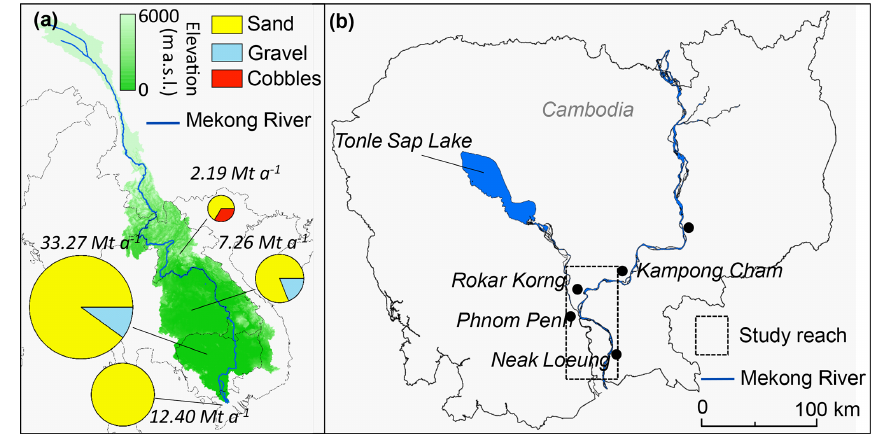
Figure 1. (a) Established sediment extraction rates (Mtyr − 1 ) across the Mekong River basin in 2013. The composition and volume of material extracted are disaggregated by country, taken from Bravard et al. (2013). The size of the pie charts scales with the volume extracted. (b) Location of the study reach in Cambodia (dashed box) from Kampong Cham to the Vietnamese border. Major river channels and lakes are highlighted by blue